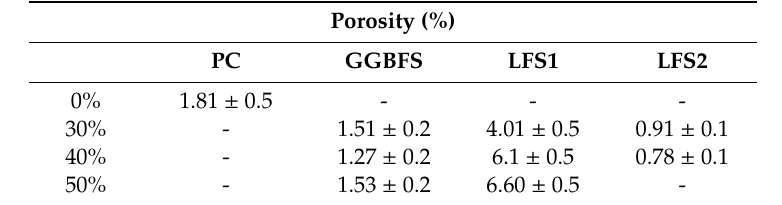
Table 4. Porosity of the mixtures.